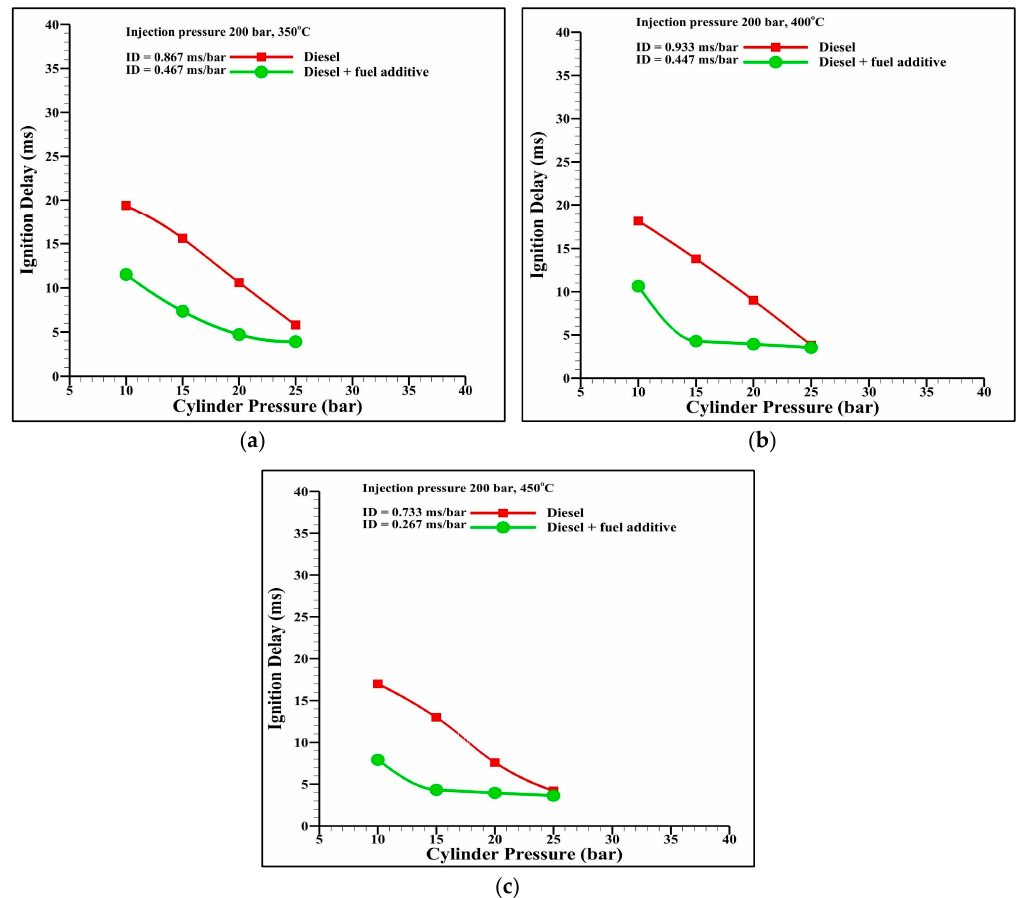
Figure 5. ID deviation of diesel and diesel with fuel additive at injection pressure 200 bar. ( a ) HST 350; ( b ) HST 400; ( c ) HST 450.